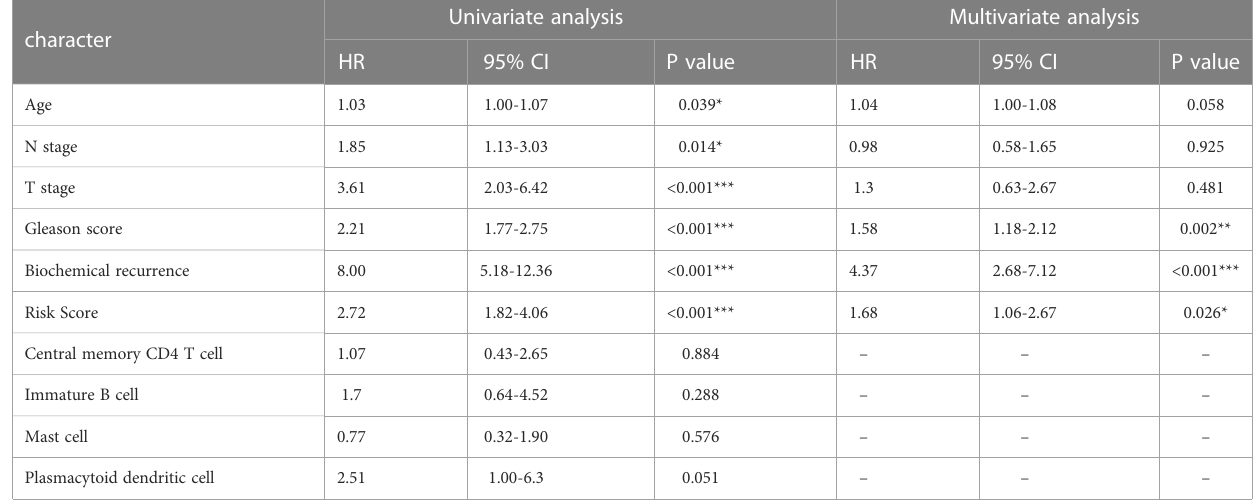
TABLE 1 Univariate and multivariate Cox regression analysis of risk score and other clinicopathological factors for PFS in TCGA cohort.